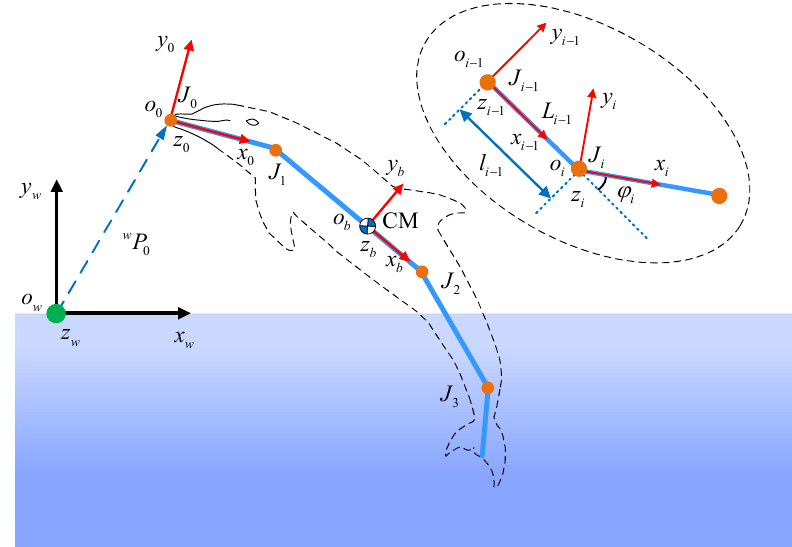
Figure 3. Illustration of coordination frames and